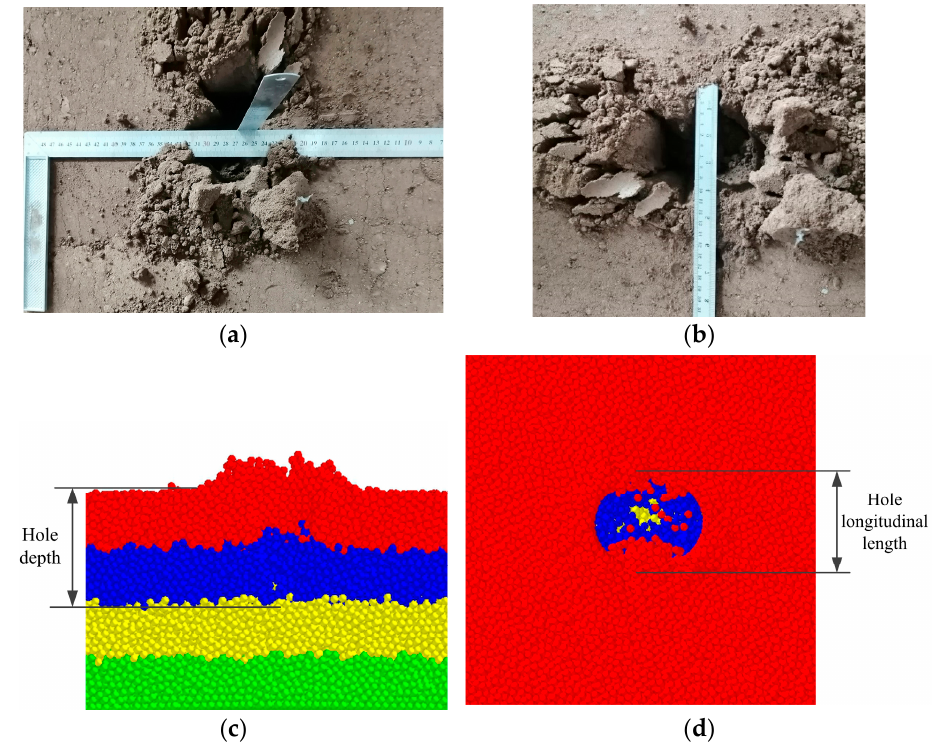
Figure 4. Hole ‐ size parameters. ( a ) Test hole depth; ( b ) test hole longitudinal length; ( c ) simulated hole depth; and ( d ) simulated hole longitudinal length.